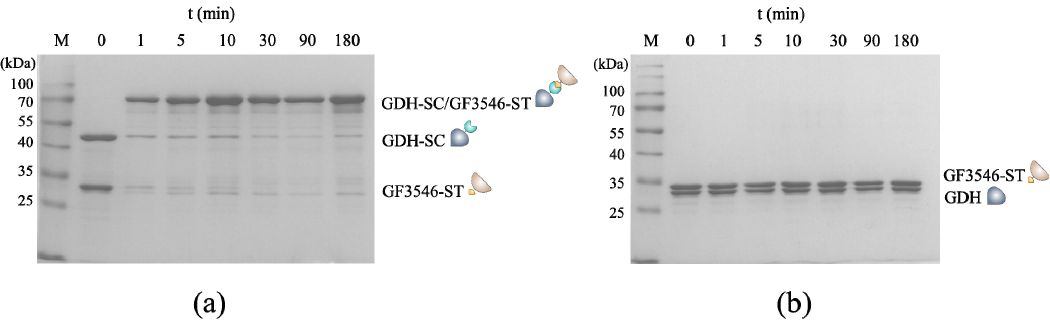
Figure 1. Kinetic analysis of the ST / SC-mediated conjugation of equimolar amounts (35 pmol) of GF3546-ST with ( a ) GDH-SC or ( b ) GDH, respectively. (Coomassie stained 12% SDS-PAGE gels, M: Color Pre-stained Protein Standard).